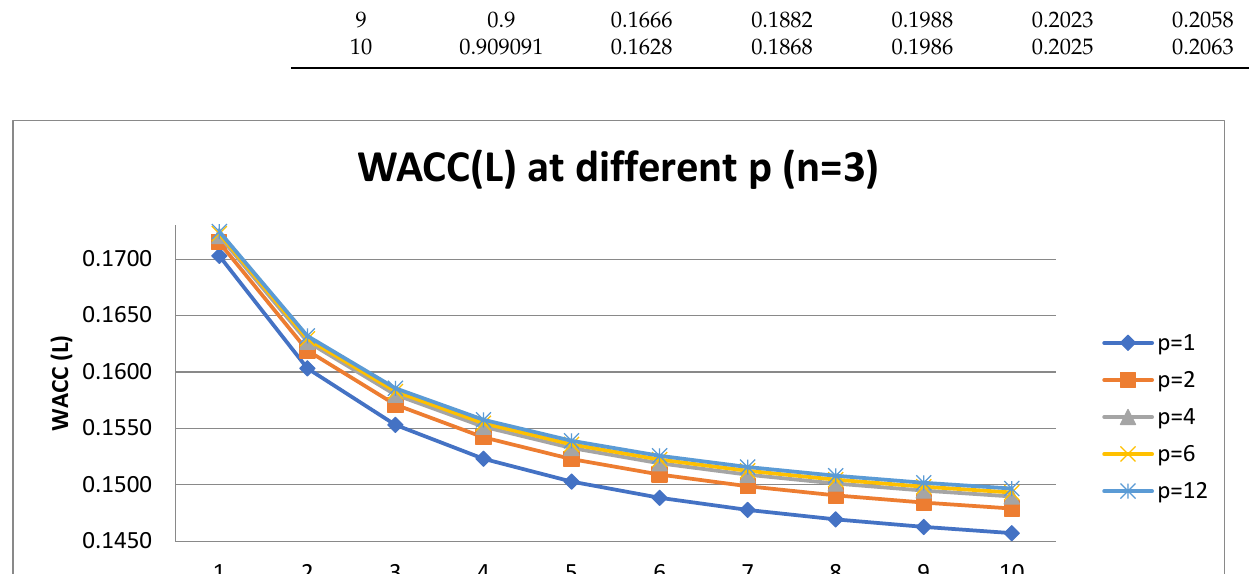
Figure 1. The dependence of the WACC on the leverage level (L) of a three-year-old company for advance profit tax payments with frequencies of p = 1, 2, 4, 6 and 12.